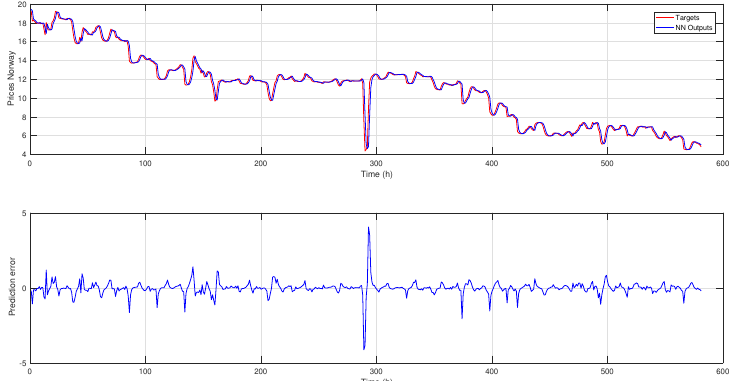
Figure 9. Energy price forecasting for Italy time series data.